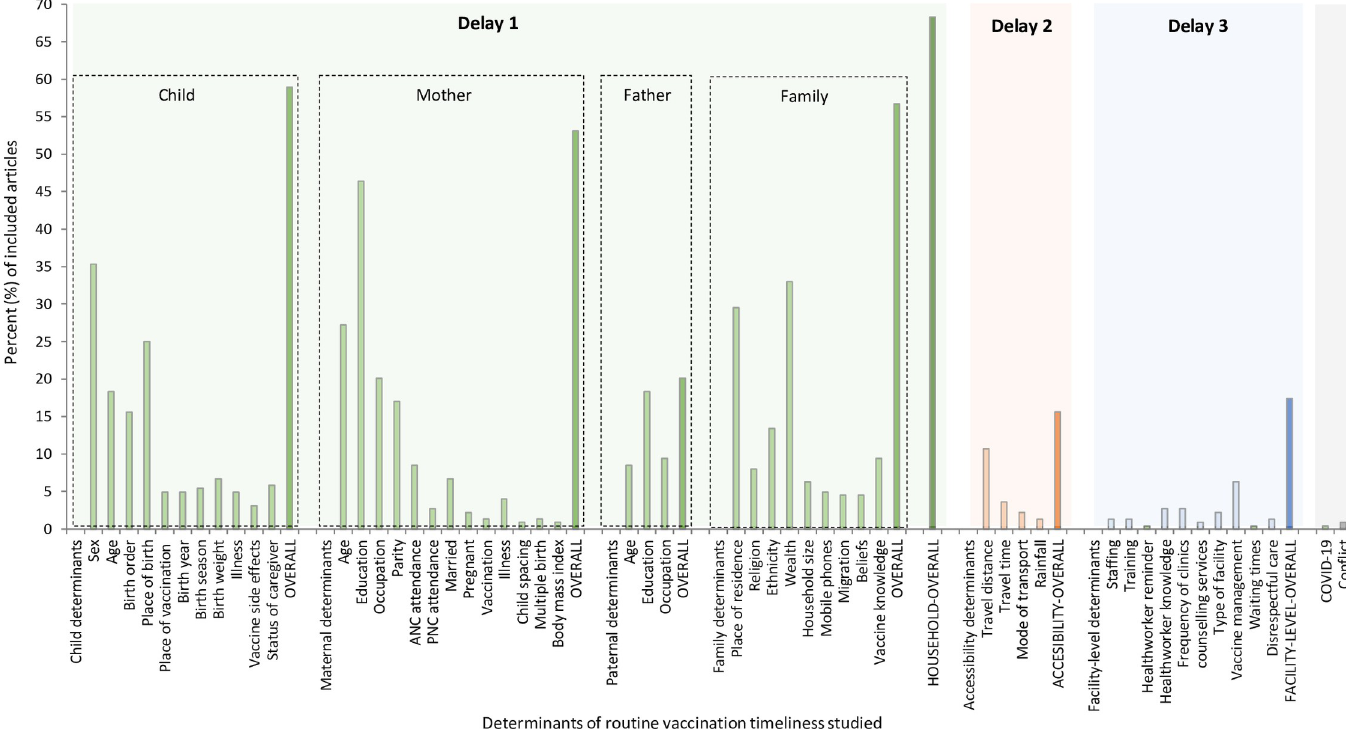
Fig 5. Determinants of the timeliness of routine childhood vaccination studied in low-and middle-income countries, 1978–2021. Note : Delay 1, 2, and 3 are based on the 3-delay conceptual framework developed by Thaddeus and Maine [21].